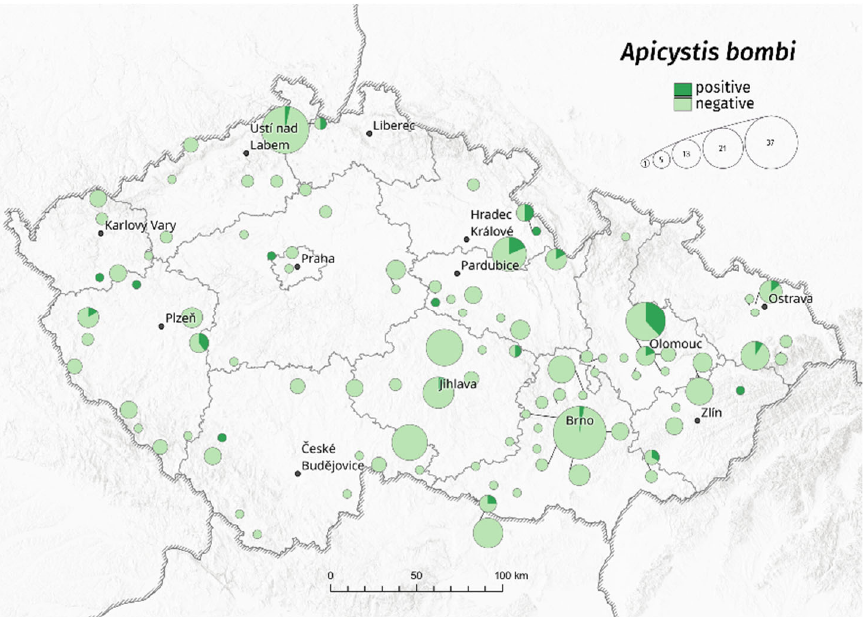
Figure 2. Sampling locations and the ratio of Apicystis bombi infection to uninfected bumblebees in the Czech Republic. The circles reflect the number of samples in sampling locations.